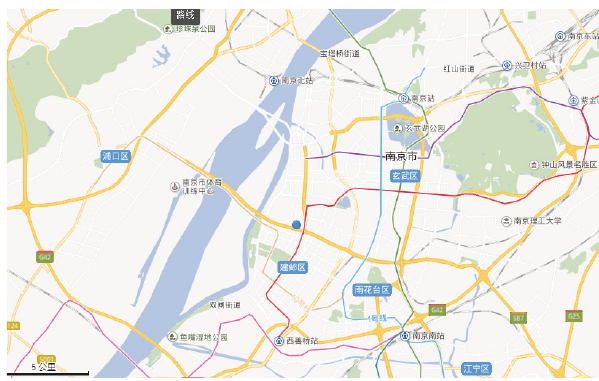
Figure 1: Nanjing’s Transportation Network (source: Baidu